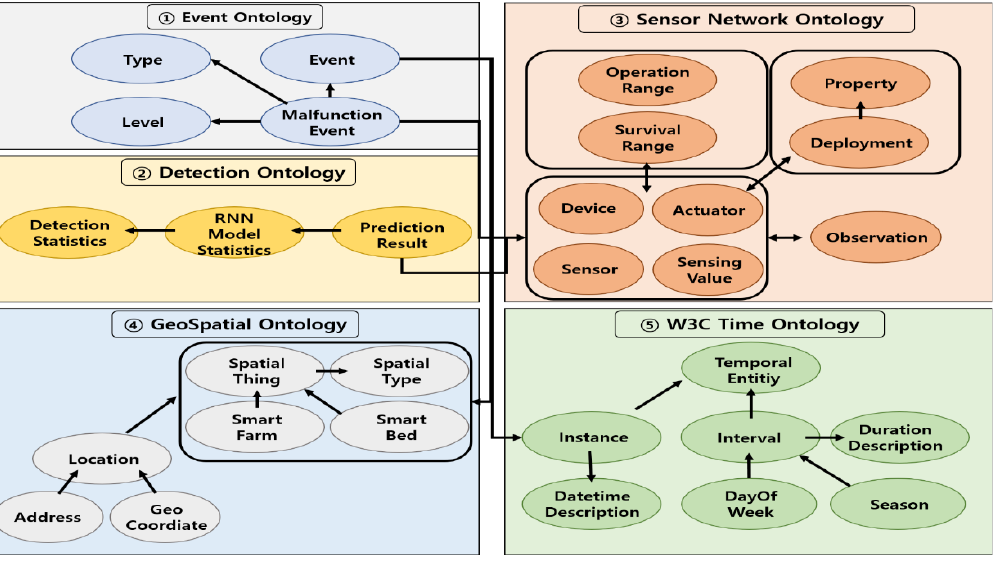
Figure 8. Relationships of various ontologies implemented in the malfunction detection system.